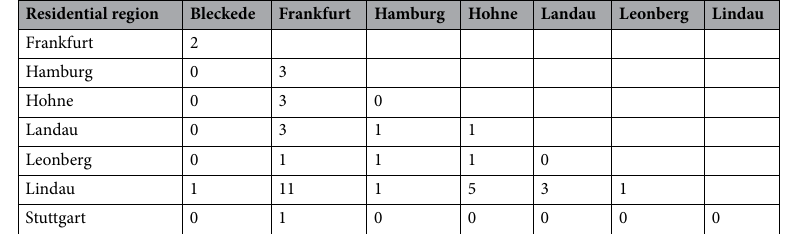
Table 6. Overview on the number of partial consensus ROHs shared by stray cats from two different residential